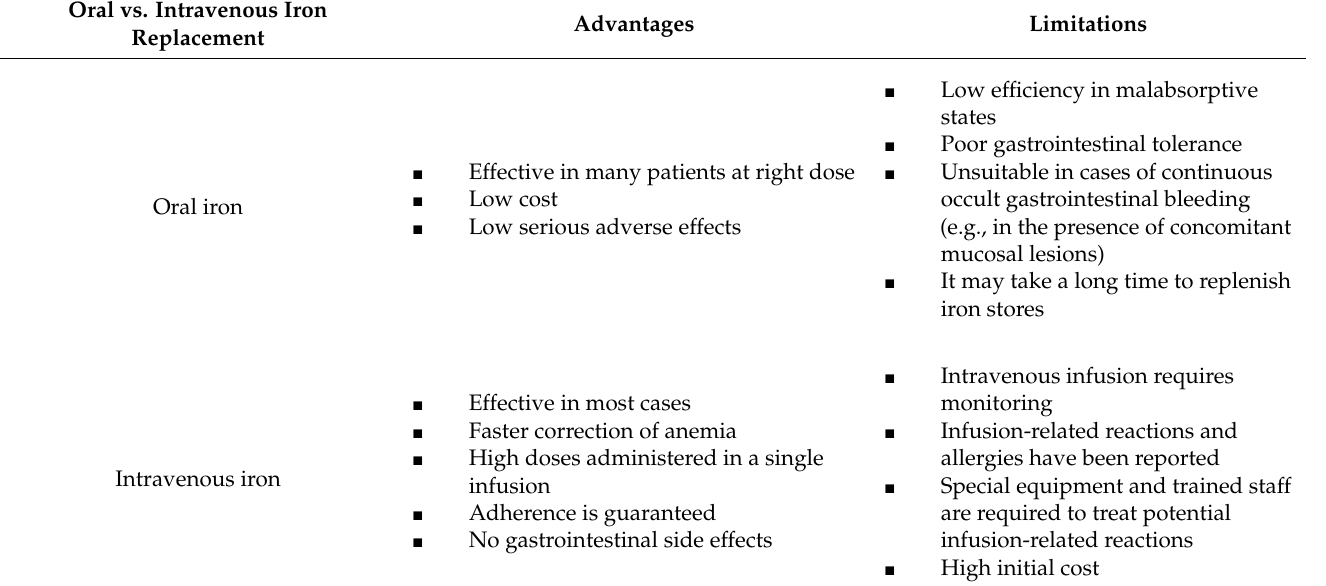
Table 5. Comparative of oral and intravenous iron in the management of